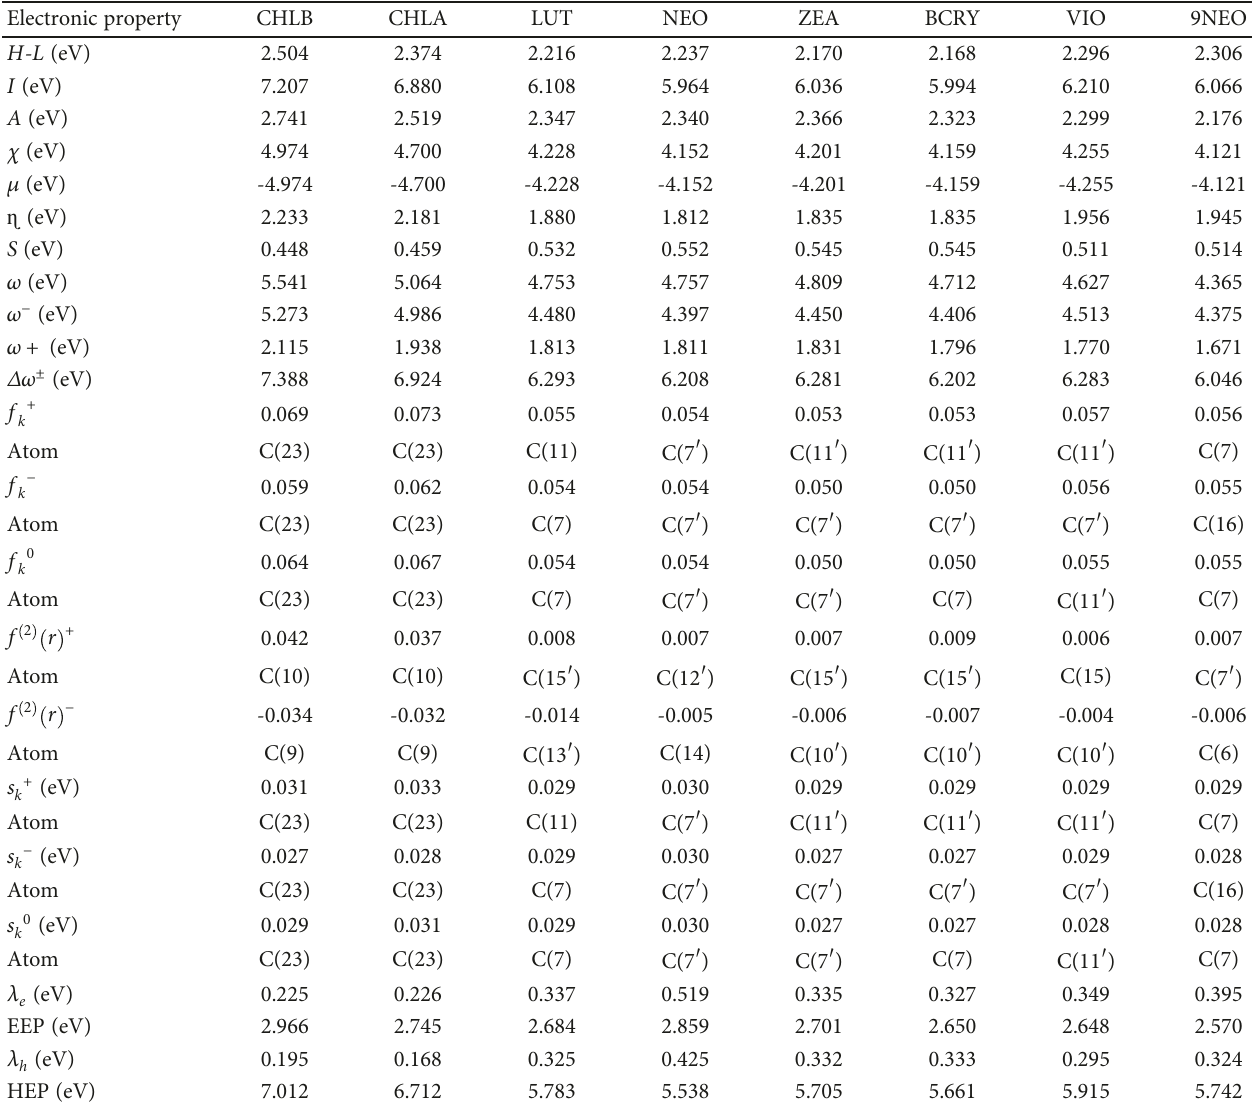
Table 2: Associated energies and chemical reactivity indexes (EP (electronic properties)) for the tested pigments at the gas phase (highest values are shown for local reactivity